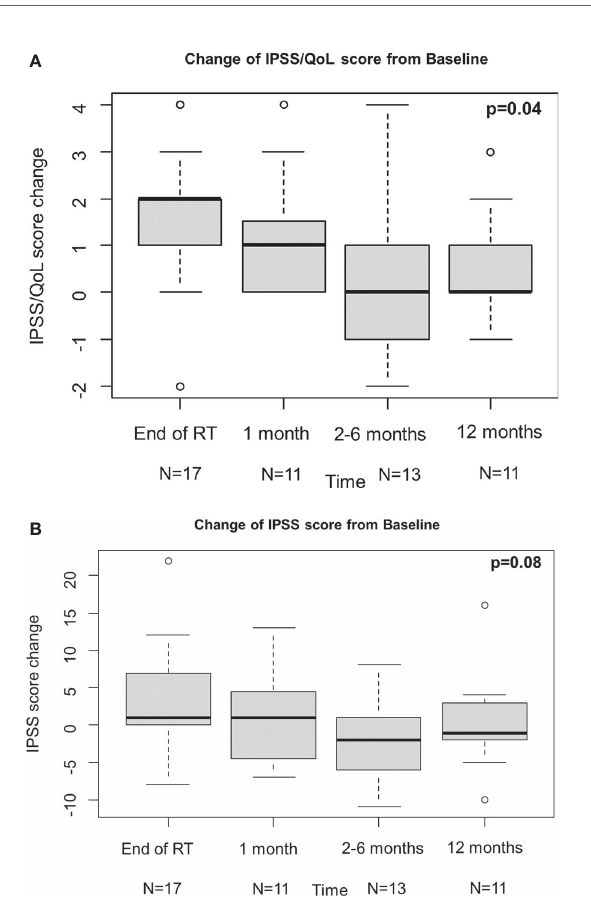
FIGURE 2 | Results of IPSS/QoL (A) and IPSS (B) . IPSS, international prostatic symptoms score; QoL, quality of